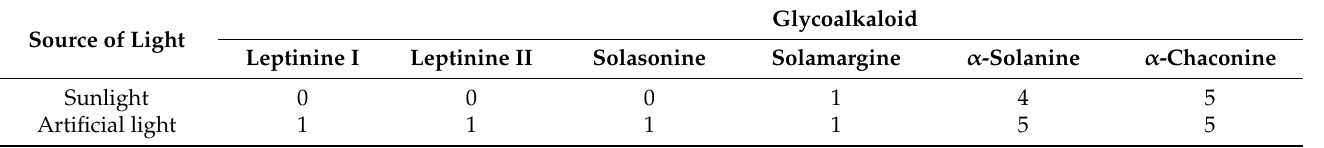
Table 2. Glycoalklaoids detected in cv. Agria 15 days after exposure to sunlight or artificial light and their amount 1 in potato